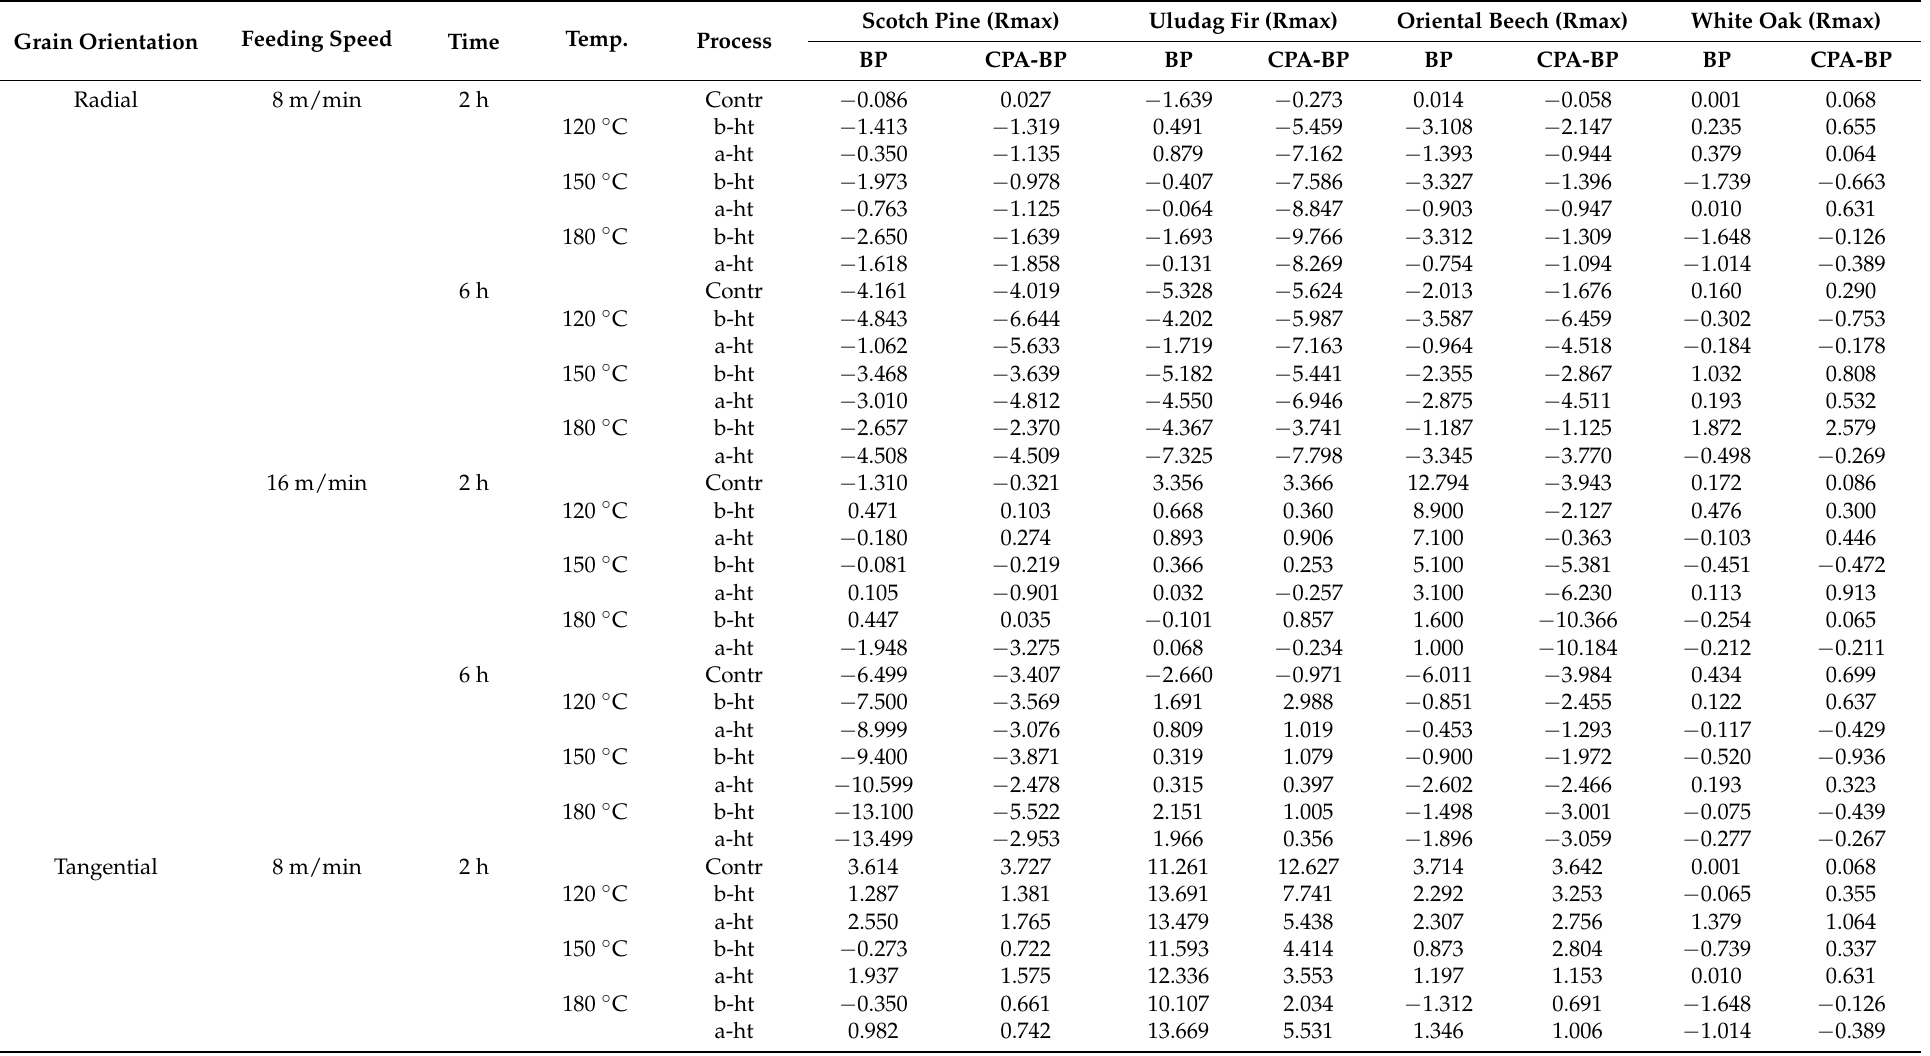
Table 9. ERROR comparison (surface